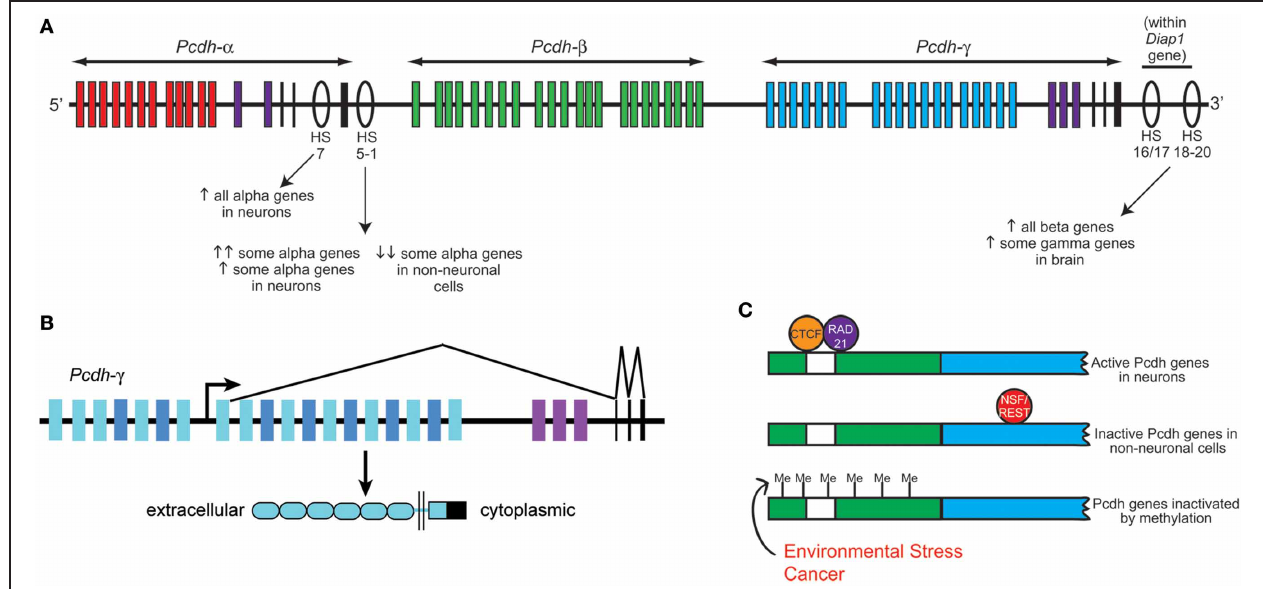
FIGURE 2 | Clustered protocadherin gene regulation. (A) Schematic of the Pcdh - α , - β , and - γ clusters found in the mammalian genome. Pcdh- α 1-12 variable exons are shown in red, Pcdh- β genes in green, Pcdh- γ A and B subfamily variable exons in blue, and the homologous Pcdh- α and - γ C family variable exons in purple. Pcdh- α and - γ constant exons are shown in black. Several DNase I hypersensitive sites (HS) that have been identified as enhancers are shown as ovals, with their reported effects on clustered Pcdh gene expression noted below. Schematic shows approximate locations along the chromosome but is not to strictly to scale. (B) Schematic of the mouse Pcdh- γ cluster showing an example pattern of gene transcription and splicing. Each variable exon has its own upstream promoter from which transcription is initiated. A long transcript through the rest of the cluster is subsequently spliced such that each transcript contains only the 5 (cid:3) -most variable exon